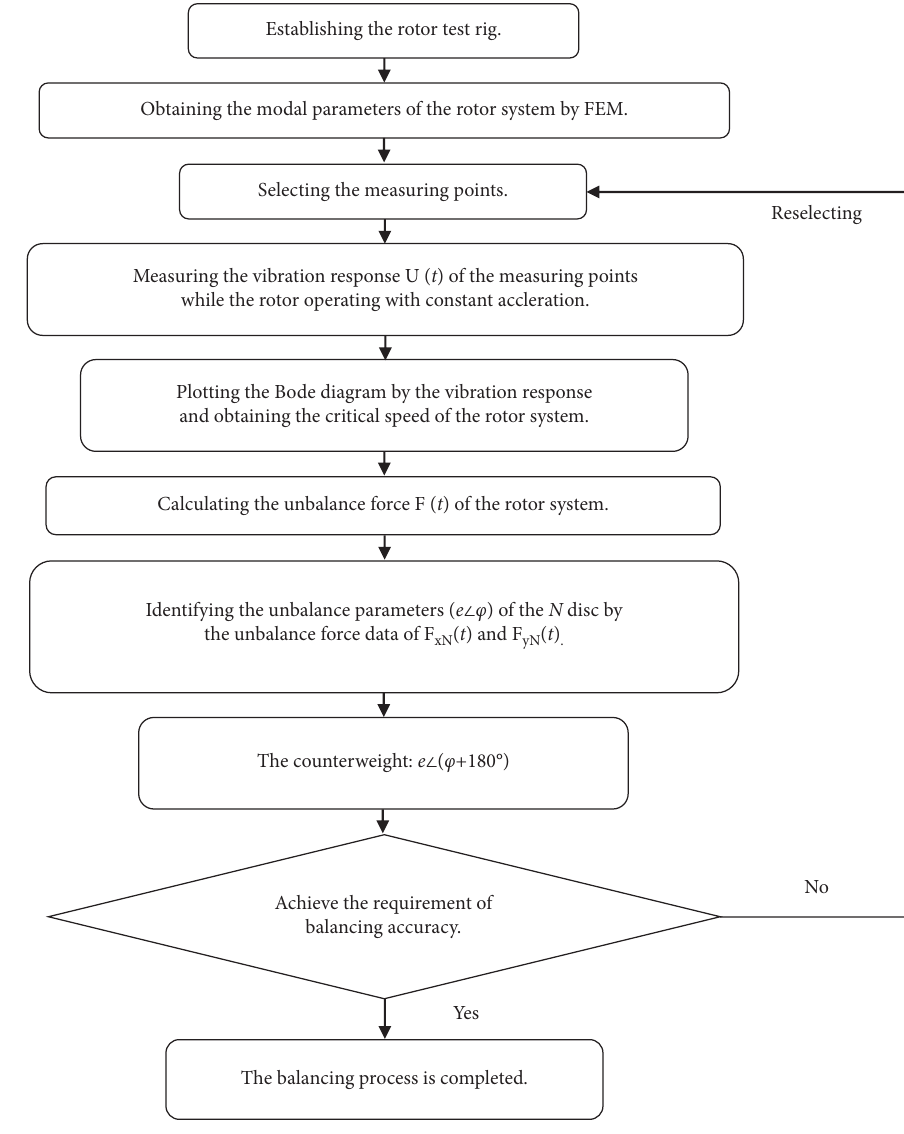
Figure 1: The balancing process of the